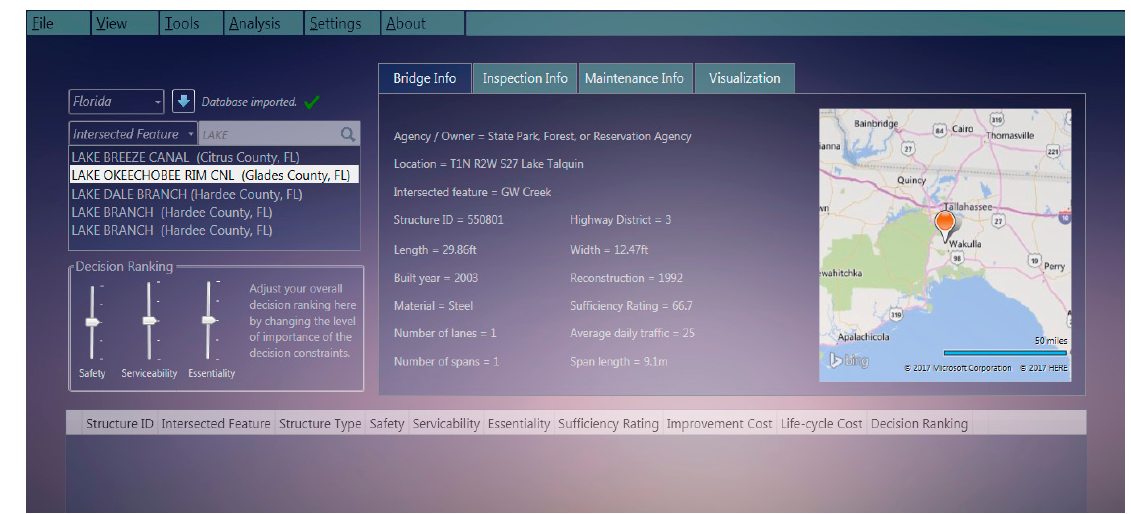
Figure 4. Web-based software implementation of the decision support framework (bridge information retrieval).